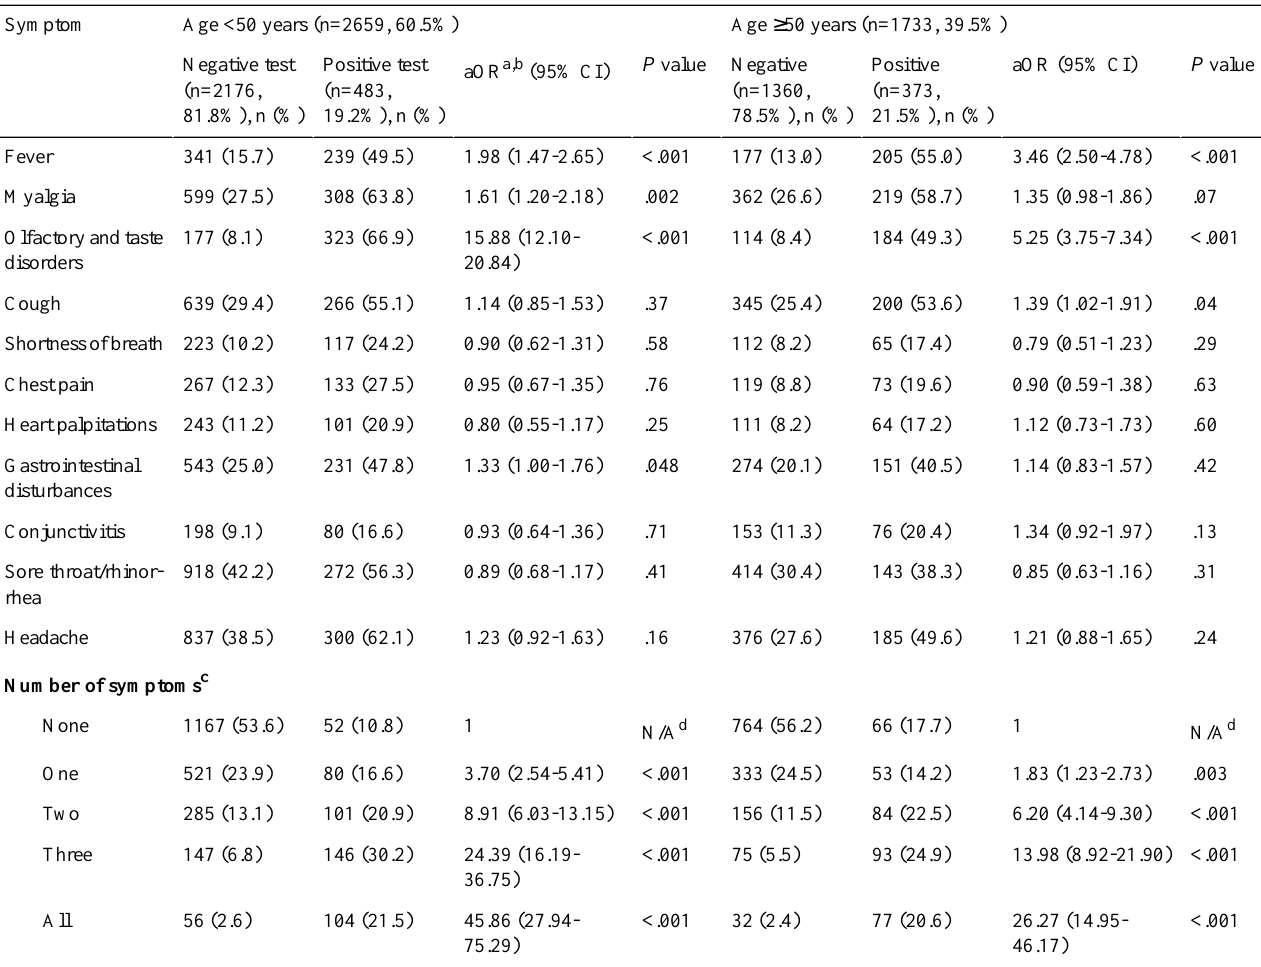
Table 5. Age-specific adjusted odds ratios of positive molecular tests in nonhospitalized respondents with known molecular test results (n=4392, subsample